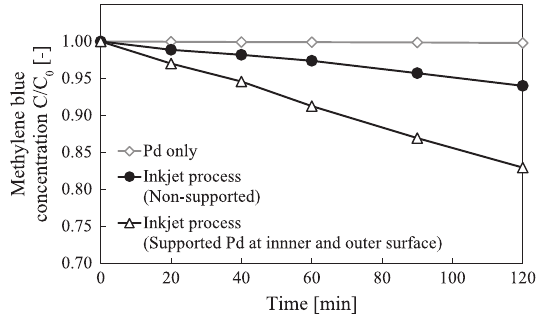
Fig. 10 Degradation behavior of methylene blue with photocatalytic ti- tania particles obtained by different processes. Reprinted with permis - sion from Ref. (Tanaka et al., 2016). Copyright: (2016)